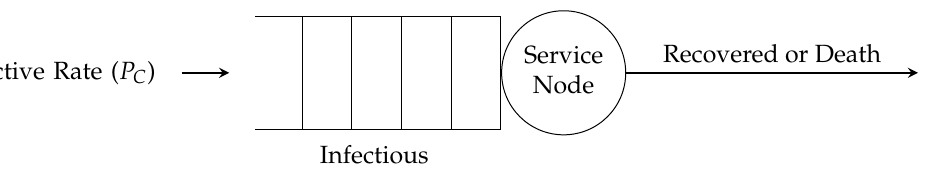
Figure 9. Queuing model for